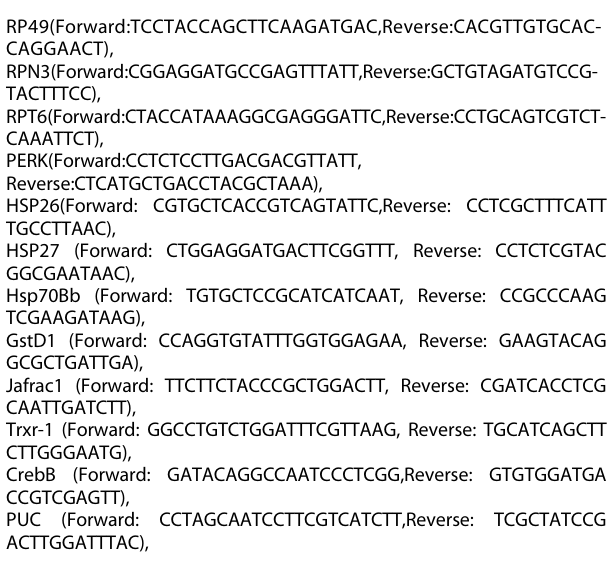
Fig. 6 Increasing CREB activity ameliorates pathogenesis in a fl y model of Huntington ’ s disease. a Ubiquitinated proteins in indirect fl ight muscles detected by anti-FK2 staining. Representative images were shown, Ref2P::GFP (green) and FK2(grey). Separate FK2 channel was shown on the right. n = 12 for each condition. Genotypes: IFM-Gal4, UAS-HTT.ex1.Q120; UAS-Ref(2)P::GFP, UAS-LacZ or IFM-Gal4, UAS- HTT.ex1.Q120; UAS-Ref(2)P::GFP, UAS-CRTC:HA . Scale bars: 10 um. b Ref(2)P::GFP positive puncta with pixel size bigger than 30 was quanti fi ed at different timepoints. n = 9 for each condition. Student ’ s t -test for statistical analysis. ** p < 0.01. *** p < 0.001. Genotypes for a , b IFM-Gal4, UAS- HTT.ex1.Q120; UAS-Ref ( 2 ) P::GFP, UAS-LacZ or IFM-Gal4, UAS-HTT.ex1.Q120; UAS-Ref(2)P::GFP, UAS-CRTC:HA . c Chymotrypsin-like proteasomal activity (measured with fl uorescence Suc-LLVY-AMC) in thoraces was quanti fi ed. AMC fl uorescence in an hour was normalized with protein level. Student ’ s t-test for statistical analysis. * P < 0.05. *** P < 0.001. 8 thoraces were tested for each condition. d Chymotrypsin-like proteasomal activity in thoraces of 20d-old fl ies was quanti fi ed after treatment with miltefosine (MFS) (5days, 5 mg/ml) or GDC0941 (3days, 2 mg/ml). Student ’ s t -test for statistical analysis. ** P < 0.01. 10 thoraces were tested for each condition. e Protein refolding capacity monitored by luciferase recovery after denatured at 42 °C for 5 mins. Experiments were performed in triplicates. Student ’ s t -test for statistical analysis. * P < 0.05. 10 thoraces were tested for each condition. f , g Climbing ability of 20d-old fl ies was examined with indicated genotypes. Student ’ s t - test for statistical analysis. Females were tested in f and male tested in panel g . *** p < 0.001. n = 25 for each condition. h Lifespan of female fl ies with indicated genotypes. n = 50-65 for each condition. Three independent replicates were measured. Log rank was performed for statistical analysis. **** p < 0.0001 between fl ies with genotypes IFM-Gal4, UAS-HTT.ex1.Q120; UAS-CD8::RFP and IFM-Gal4, UAS-HTT.ex1.Q120; UAS- CRTC:HA . Genotypes for c – g IFM-Gal4, UAS-HTT.ex1.Q120; UAS-CD8::RFP or IFM-Gal4, UAS-HTT.ex1.Q120; UAS-CRTC:HA , or IFM-Gal4; UAS-CD8::RFP or IFM-Gal4; UAS-CRTC:HA